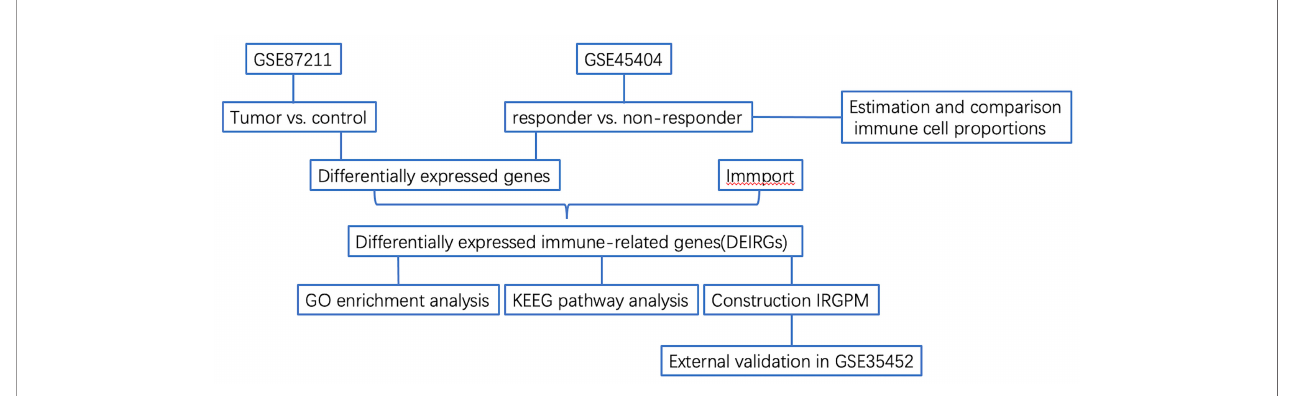
FIGURE 1 | Flowchart describing the process used to identify DEIRGs and construct IRGPM of